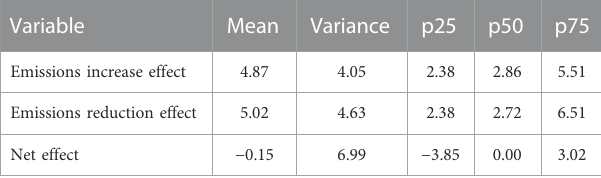
TABLE 4 Estimated net effect (%) of the digital economy on air